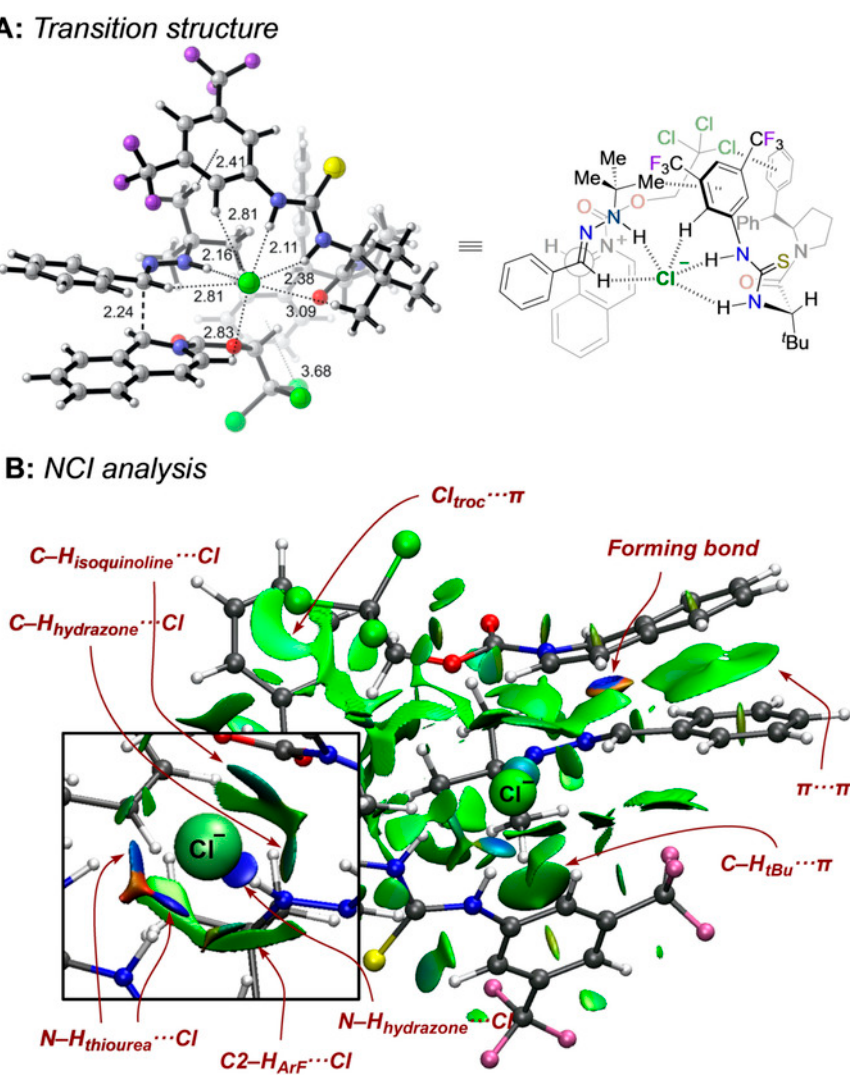
Figure 51. ( A ) TS structure and ( B ) NCI TS analysis of the asymmetric addition of N - tert -butylhydrazones to isoquinolinium ions. Reprinted and adapted from Angewandte Chemie International Edition with permission from Wiley [98].